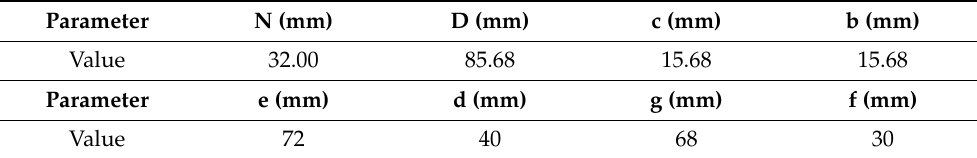
Figure 6. ( a ) Real transformer and ( b ) simulation model. Table 1. The transformer dimension